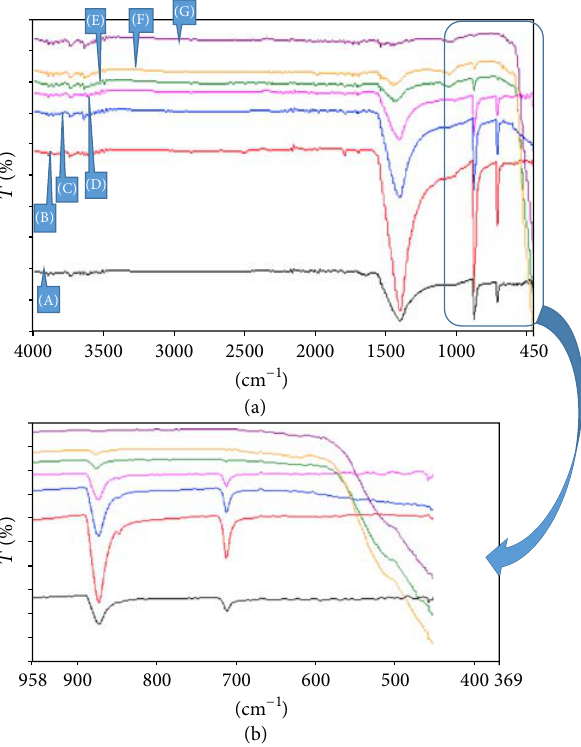
Figure 2: Raw FTIR spectra of eggshells calcinated at different temperatures of 500 (B), 600 (C), 700 (D), 800 (E), 900 (F), and 1000 ∘ C (G). Uncalcinated egg shell (A) was used as control. Gradual decomposition of carbonates (a) occurred with increasing calcinationtemperature,leadingtoinclinationsinspectraof(E),(F), and (G) as seen in (b) due to emergence of calcium oxide